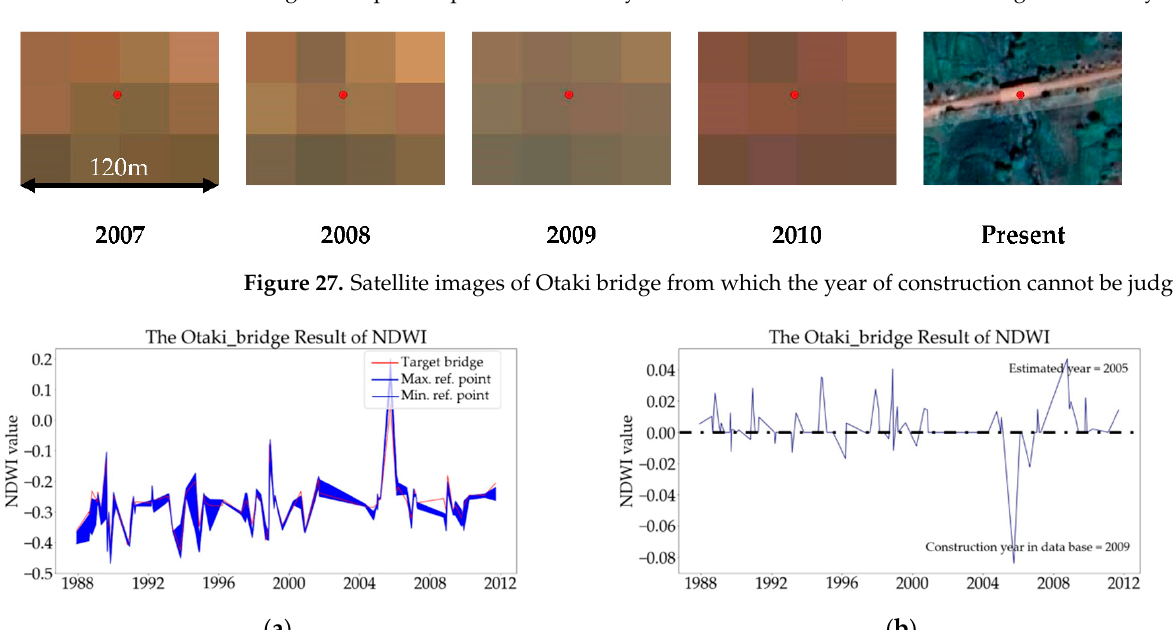
Figure 27. Satellite images of Otaki bridge from which the year of construction cannot be judged. Figure 28. ( a ) NDWI results for the O Ta Ki bridges, from which the year of construction is estimated to be 2005; ( b ) re-visualization of ( a ) showing a sudden NDWI deviation in 2005.